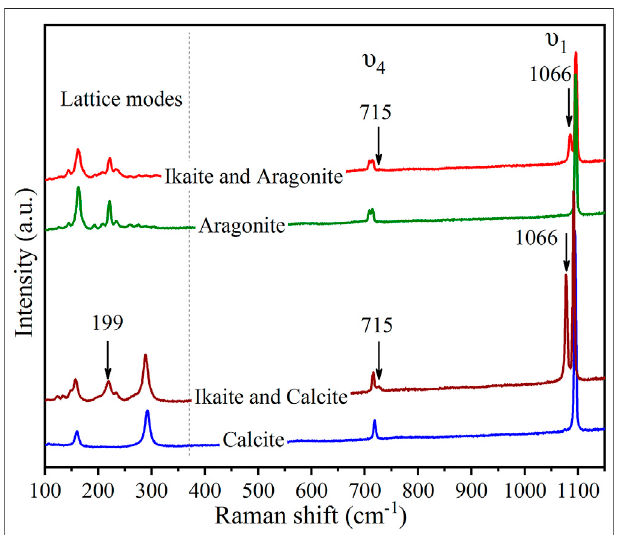
FIGURE 8 | Raman spectra of calcite, aragonite, and ikaite.